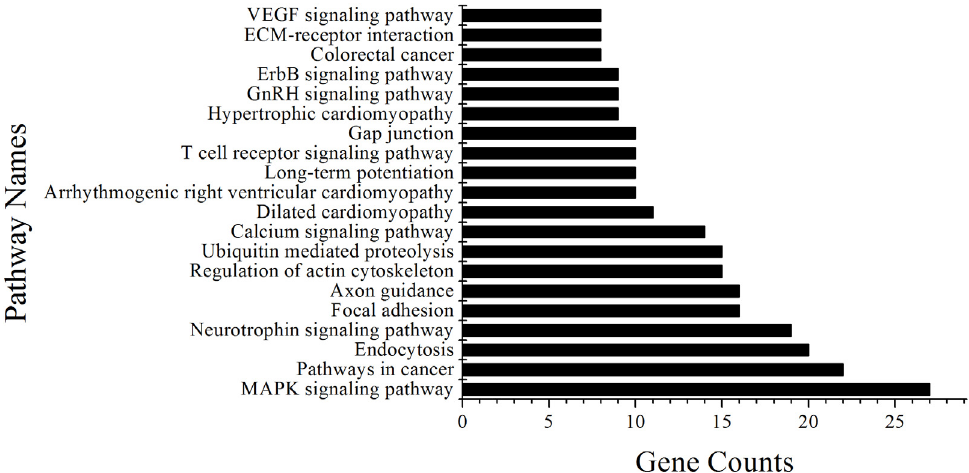
Figure 3. Top 20 pathways predicted to be targeted by differentially expressed miRNAs.